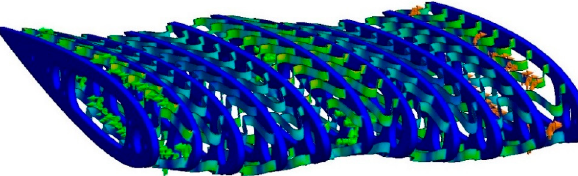
Figure 9. The static study on the honeycomb substructure with a 100 N load and a 4 cm-prescribed displacement applied (maximum displacement = 4.5 mm, and minimum factor of safety = 5.3).